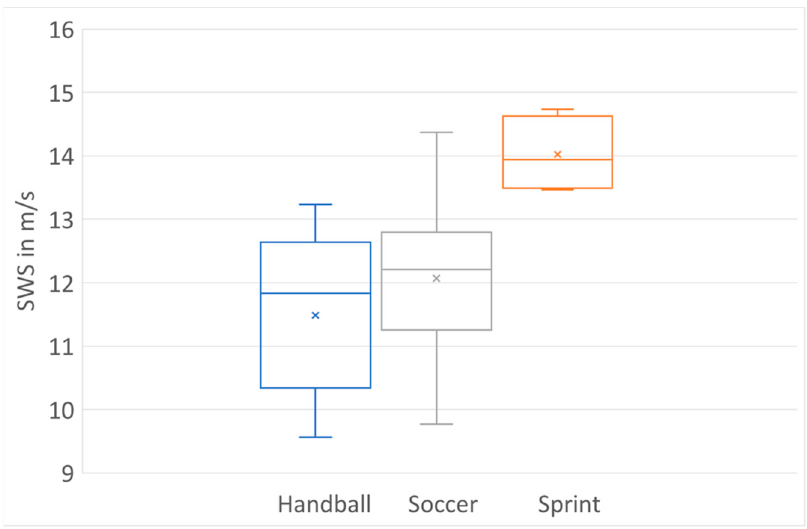
Figure 3. AT sti ff ness for male athletes in di ff erent sports. Figure 3. AT stiffness for male athletes in different In the female group (sports: handball (n = 6), volleyball (n = 14), sprint (n = 4) and hammer throw (n = 9)), professional sprint athletes (12.31 m/s (11.19–13.60)) showed sig- ni fi cantly higher AT sti ff ness compared with volleyball and handball players (VB: 10.88 m/s (10.04–11.68), HB: 10.31 m/s (8.57–11.63), p < 0.05) and hammer throwers (11.03 m/s (10.30–11.61), p < 0.05), (Figures 4 and 5). No signi fi cant di ff erence in AT sti ff ness was found between volleyball players and hammer throwers, volleyball and handball players and handball players and hammer throwers ( p > 0.05). Figure 4. AT sti ff ness values for female athletes in di ff erent sports.